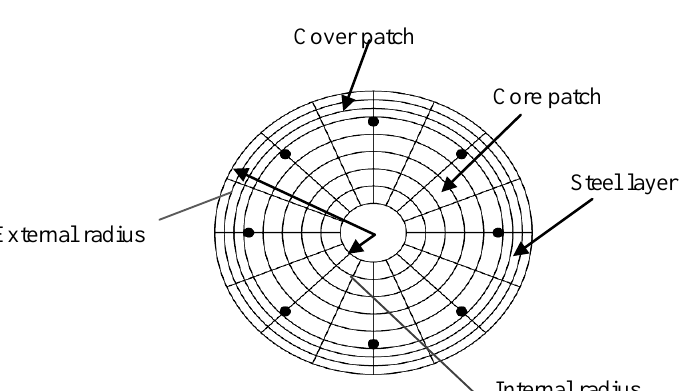
Fig. 13. Typical discretization of a typical pier cross-section into